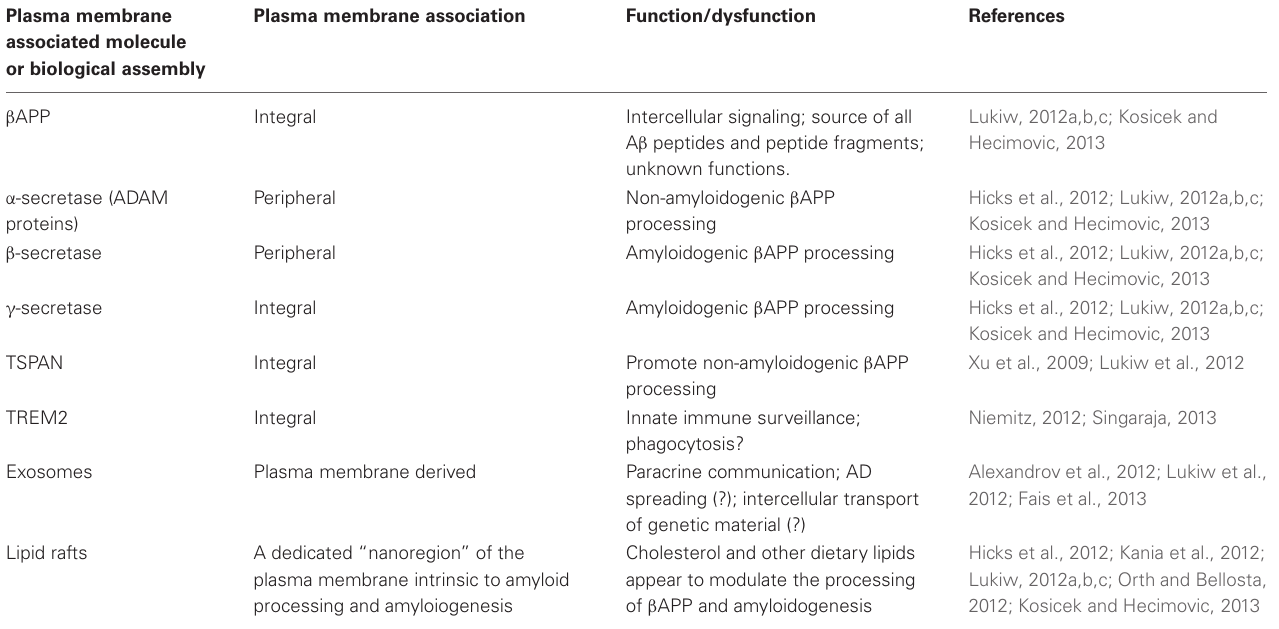
Table 1 | Role of the plasma membrane in the pathophysiology of AD. Plasma